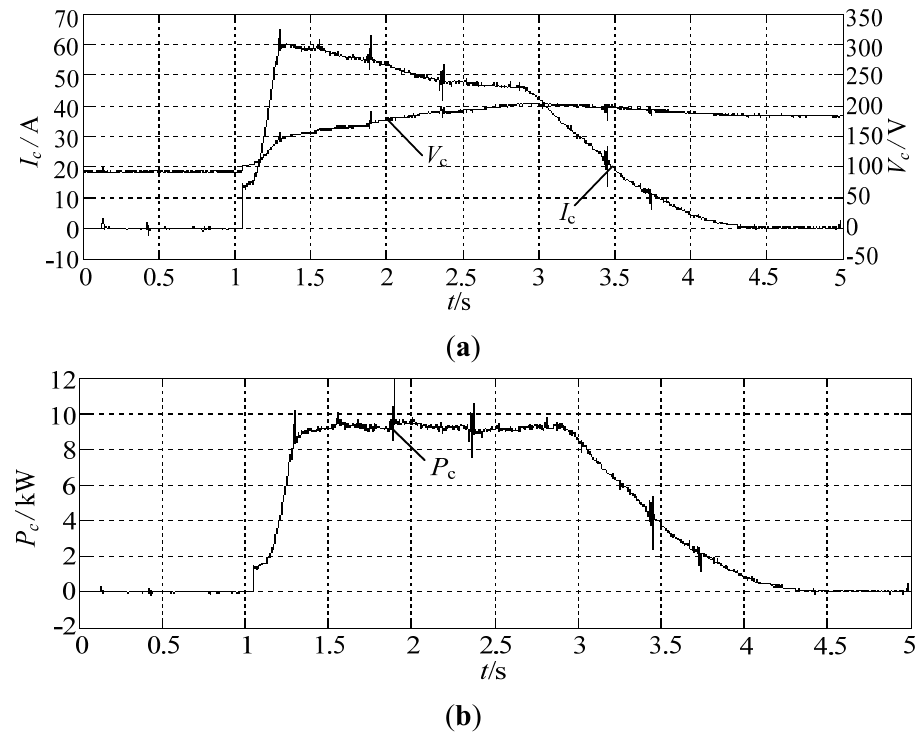
Figure 9. Charging current of the ultra-capacitors using PID controller in regenerative braking operation. ( a ) Terminal voltage of the ultra-capacitors V ( b ) charging power of the ultra-capacitors ( P